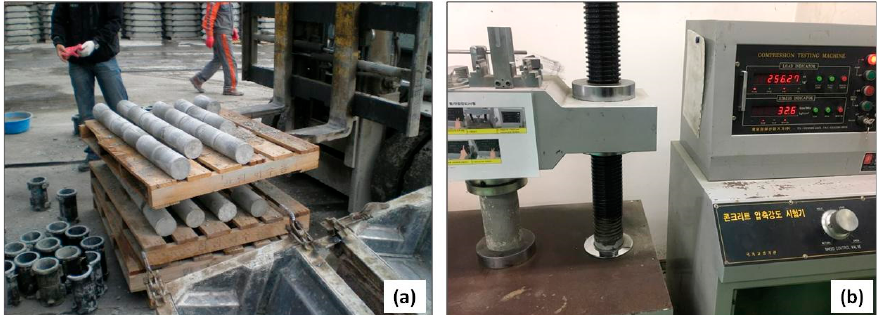
Figure 4. ( a ) Steam-cured samples being removed from molds, and ( b ) compression testing setup